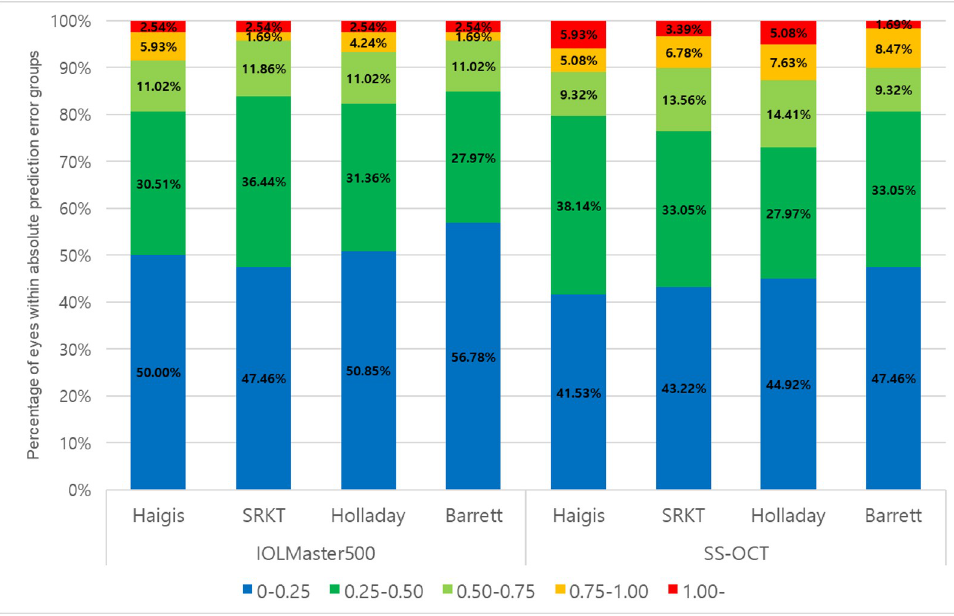
Fig 3. Stacked graph represents the percentage of eyes achieved the absolute prediction errors by four formulas with SS-OCT and PCI.